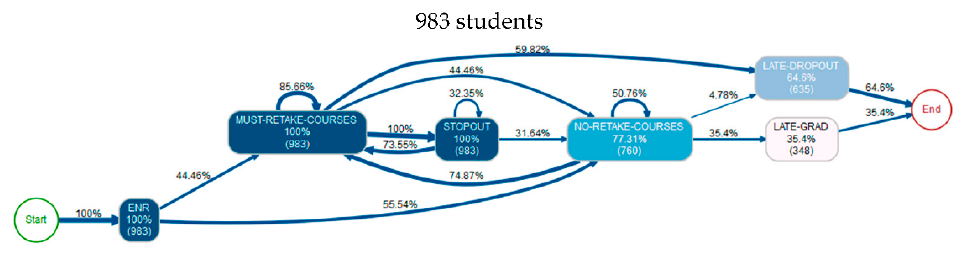
Figure 2. Educational trajectories in high-failure rate courses, according to the RETAKE-STOPOUT model, including only students who had at least one MUST-RETAKE-COURSES > STOPOUT transition, did not have NO-RETAKE-COURSES > STOPOUT transitions, and ended in LATE-DROPOUT or LATE-GRAD. The darker color of the nodes represents a higher percentage of students who went through a state. The thickness of the arrows represents the percentage of students who had transitions between both states. All values are percentages in relation to the total number of students included in the model.